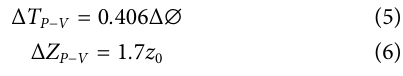
Frontiers in Materials |